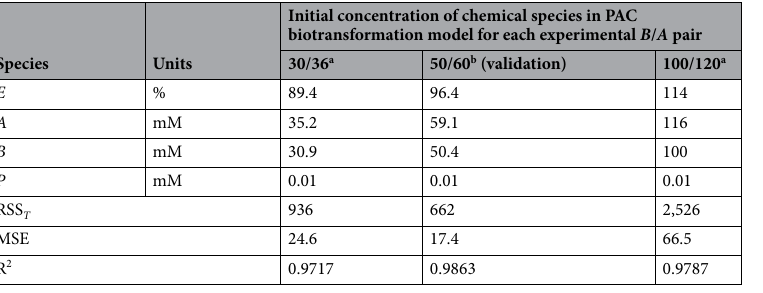
Table 3. Apparent initial concentration values of chemical species (enzyme activity ( E ), pyruvate ( A ), benzaldehyde ( B ), PAC ( P )) in the batch biotransformation processes utilized by PAC biotransformation model with corresponding individual RSS, MSE, and R 2 for partially purified C. tropicalis TISTR 5350 PDC. The initial volumetric enzyme activity for each experiment was between 1.1 and 1.5 U mL −1 with experimental benzaldehyde and pyruvate concentration levels of (30/36), (50/60), and (100/120) mM. a These experimental pairs were used in parameters determination process. b The validity of parameters in PAC biotransformation model was confirmed by this experimental